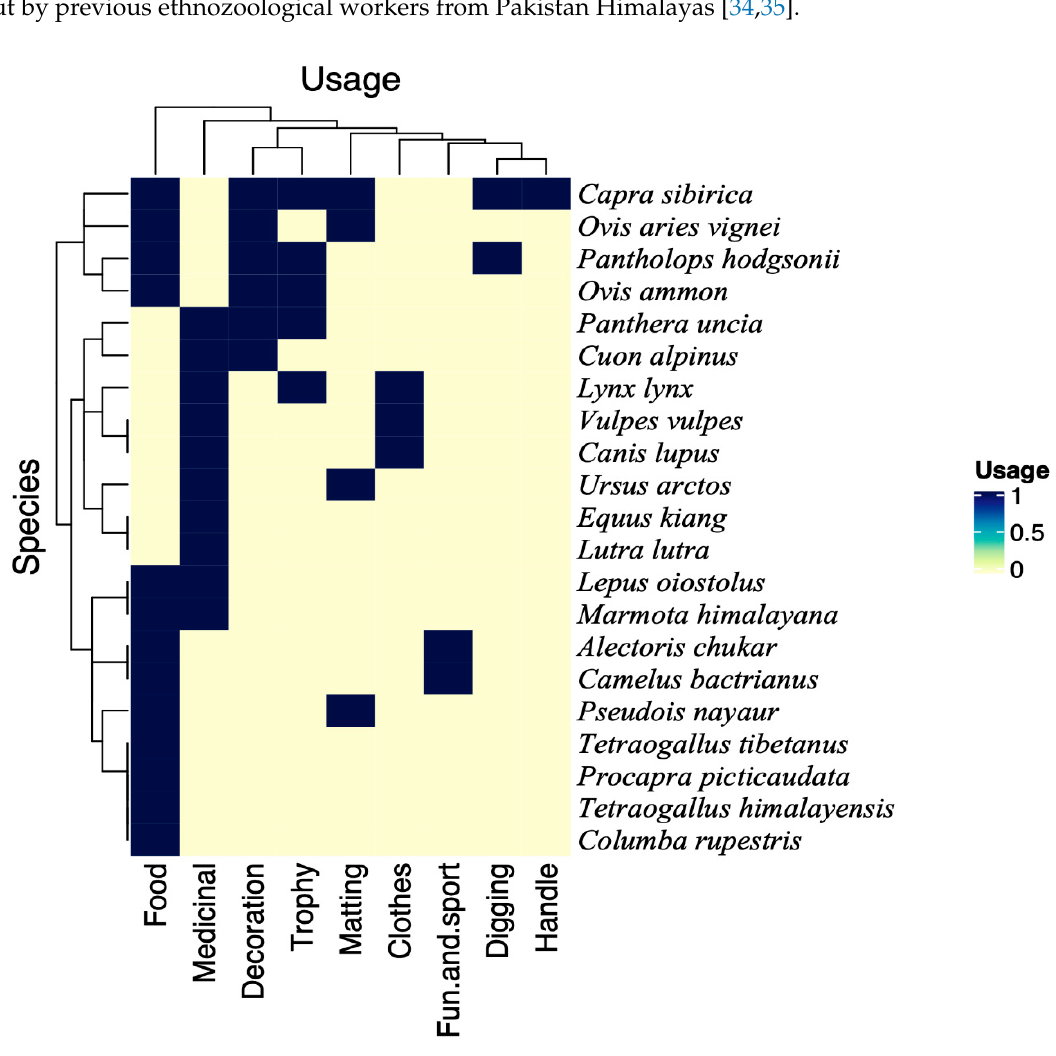
Figure 5. Cluster diagram of the fauna based on animal usage in Ladakh.